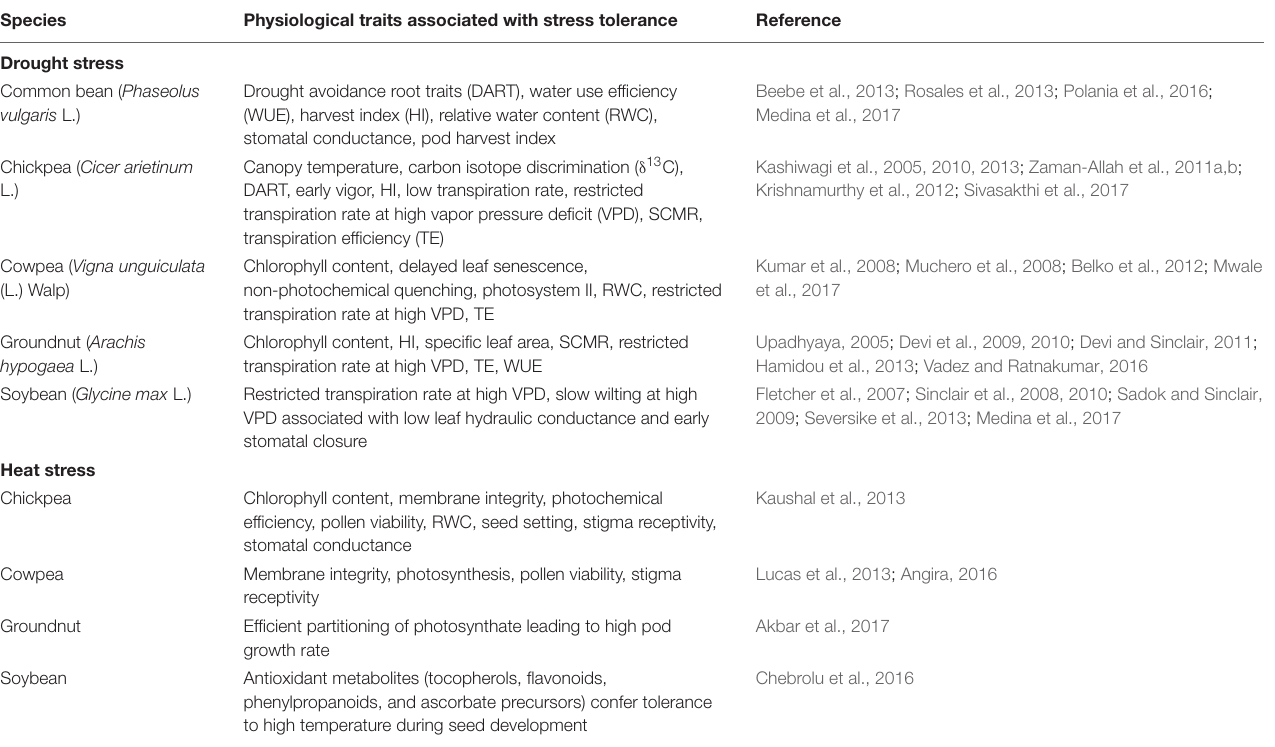
TABLE 1 | Physiological basis of drought and heat stress tolerance in grain legumes from 2005–2017. Species Physiological traits associated with stress tolerance Reference Drought stress Common bean ( Phaseolus vulgaris